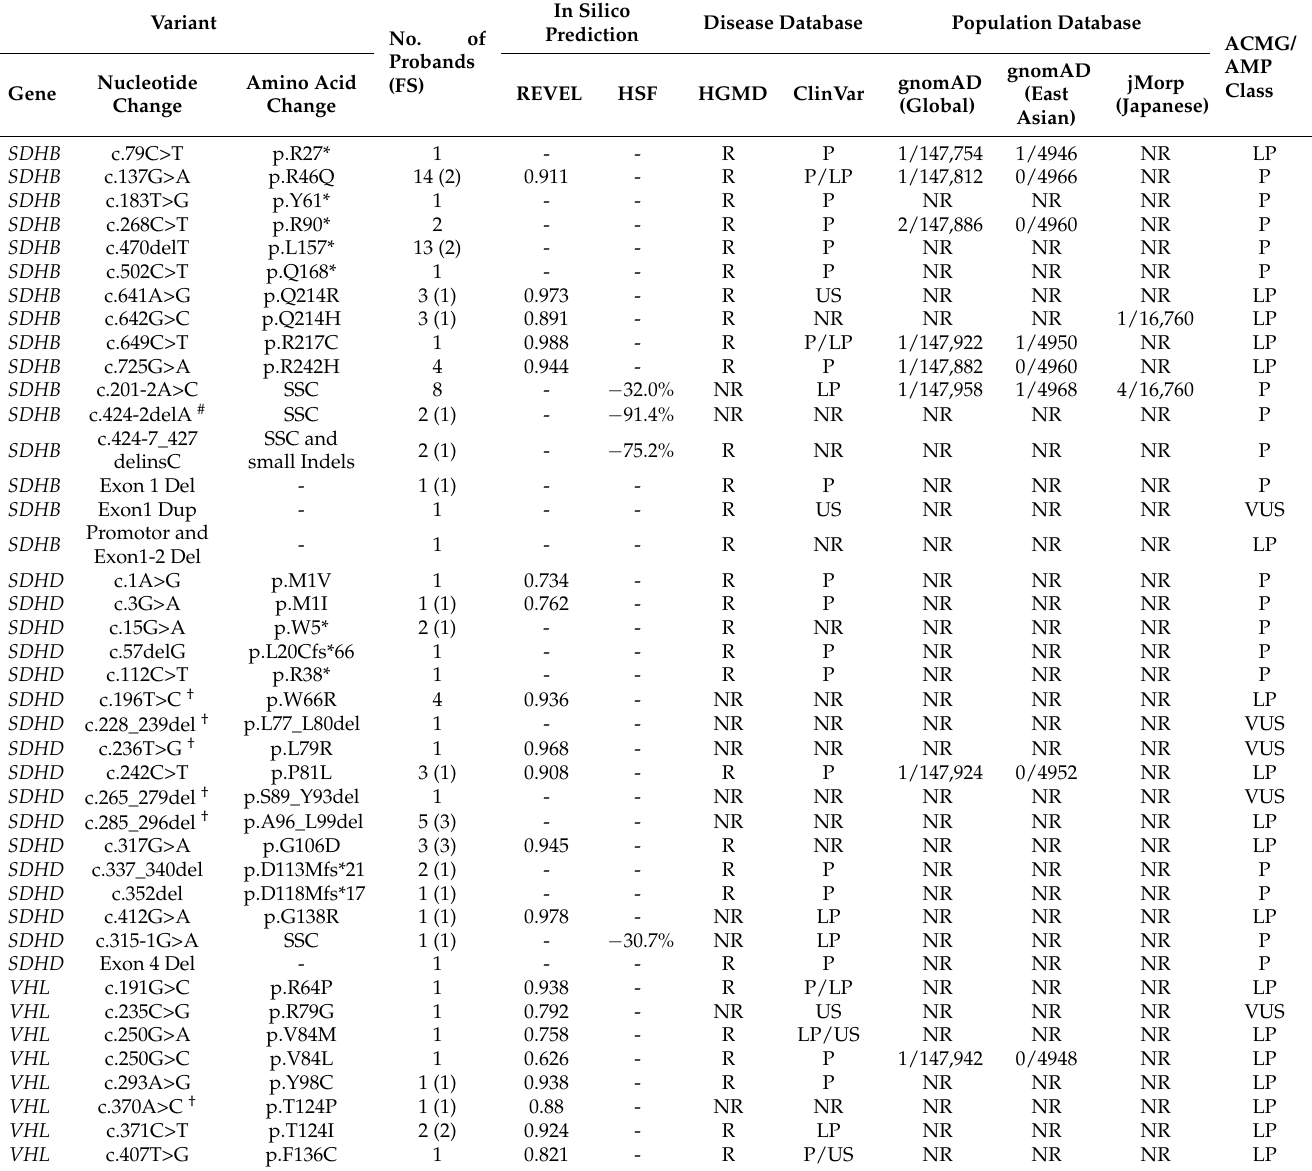
Table 2. List of identified germline